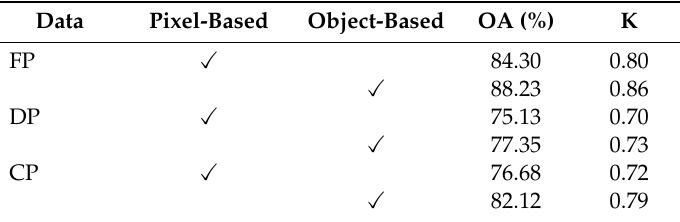
Table 10. The results of the final classification scheme in this study.